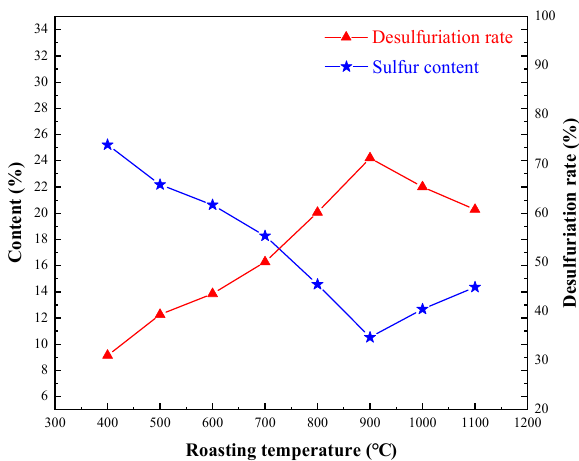
Figure 3. E ff ect of oxidizing roasting temperature on sulfur removal. Figure 3. Effect of oxidizing roasting temperature on sulfur removal.